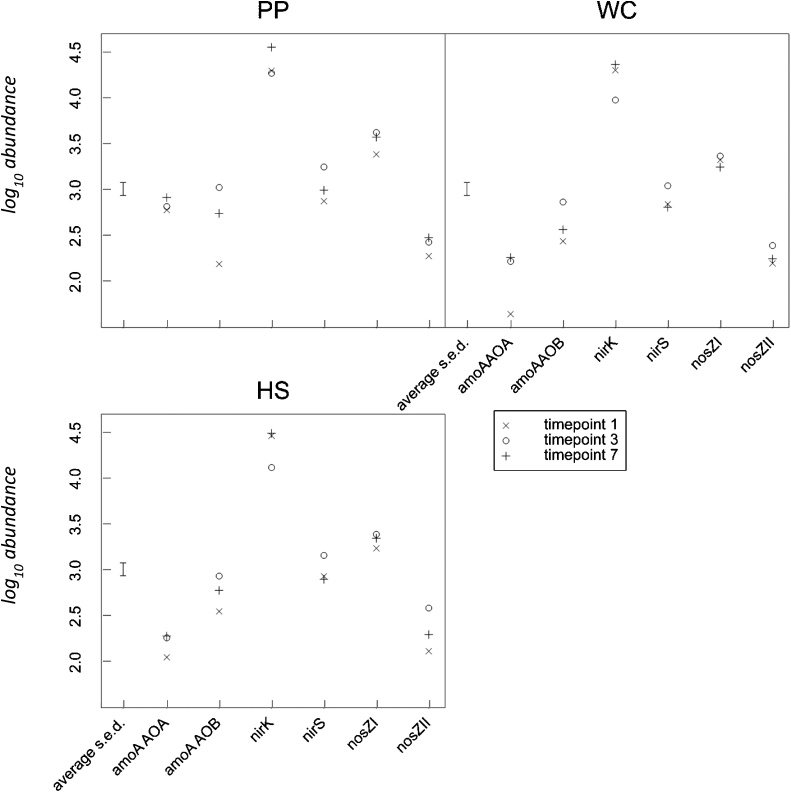
Total abundance of the amoA AOB, amoA AOA, nirK, nirS, nosZI and nosZII for all treatments within farmlets. Time point 1 = 4 days before treatment application (02/06/17); time point 3 = 24 days after treatment application (30/06/17); time point 7 = 126 days after treatment application (10/10/17). Values are expressed as log gene copy number × g−1 dry soil. PP = permanent pasture; WC = white clover/high sugar grass mixed sward; HS = high sugar grass monoculture.